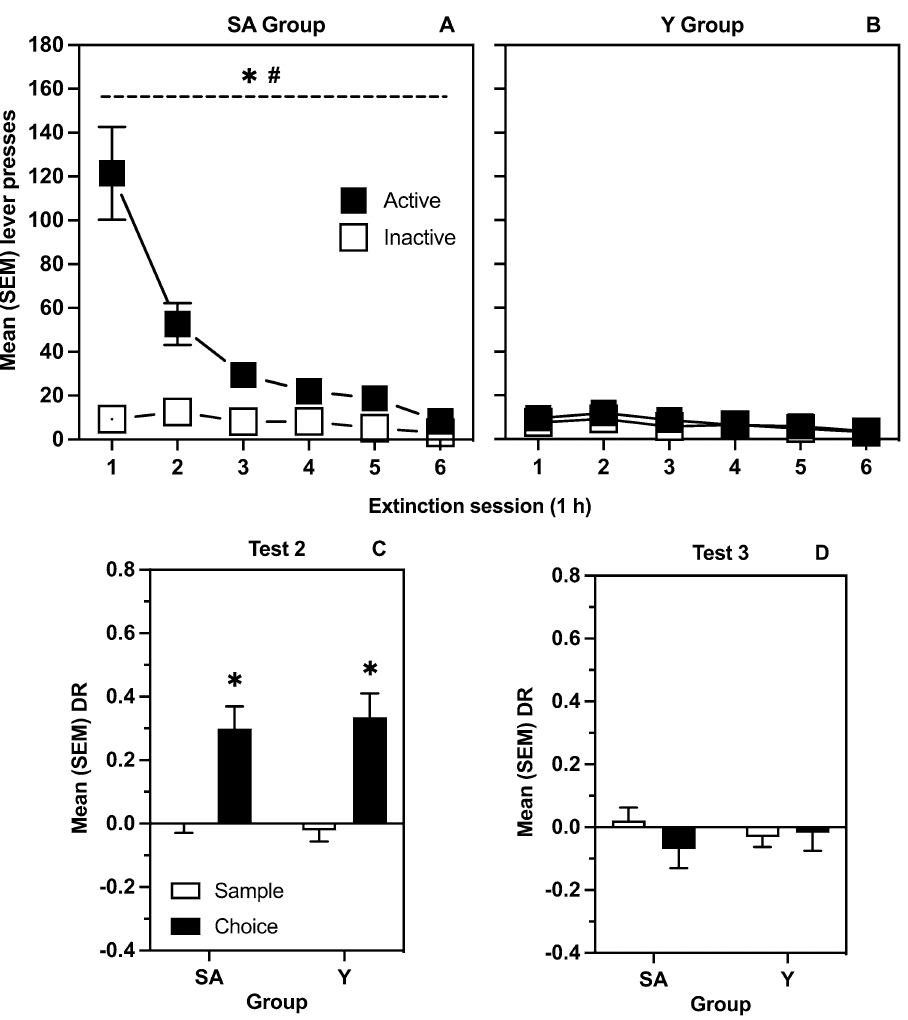
Figure 4. Effects of exposure to contextual heroin CSs on lever responses and object location memory. ( A ) mean (SEM) active and inactive lever presses for rats in the SA group during extinction. ( B ) mean (SEM) active and inactive lever presses for rats in the yoked group during extinction. The * indicates a significant difference between levers. The # indicates a significant difference in responding between groups on the active lever. ( C ) mean (SEM) DRs from sample and choice phases of SA and Y groups on the test of memory modulation by the first extinction session. ( D ) mean (SEM) DRs from sample and choice phases of SA and Y groups on the test of memory modulation by the last extinction session. The * indicates a significant difference between